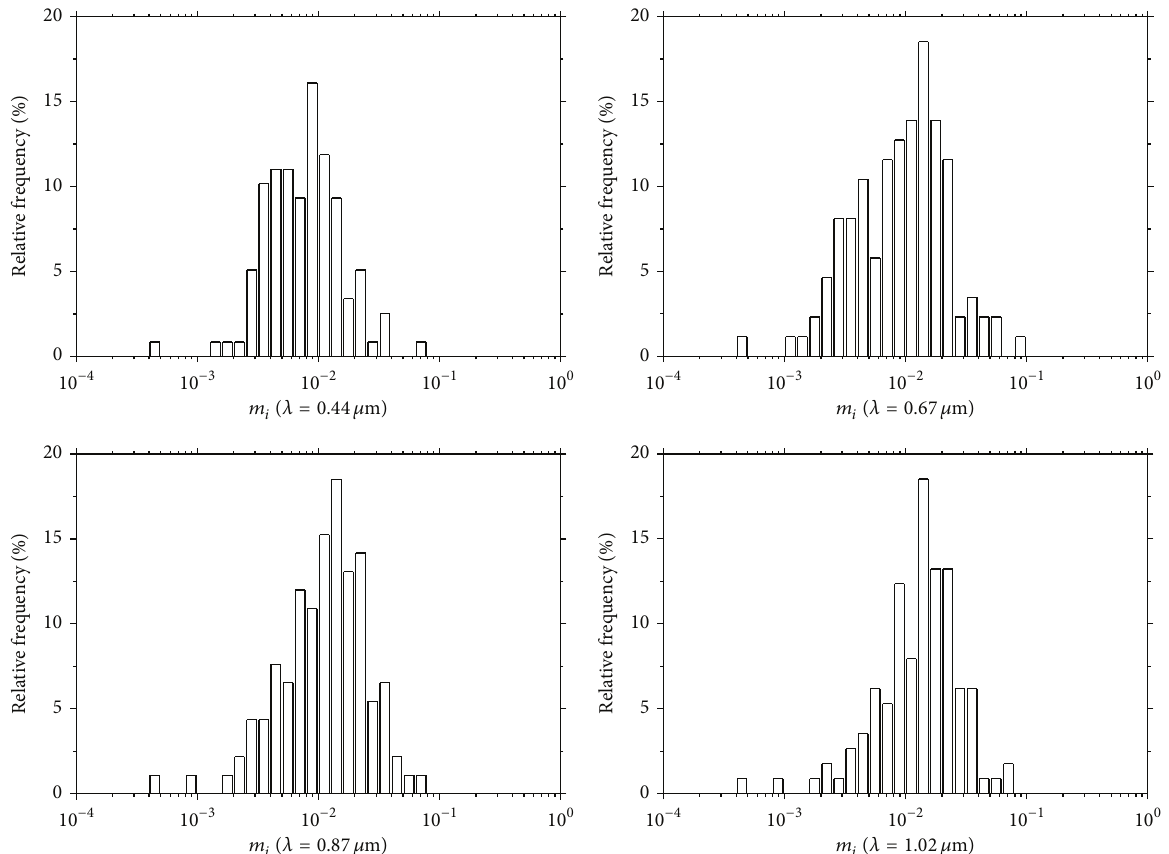
Figure 9: The histograms of the imaginary part of complex refractive index for dust aerosol at 0.44, 0.67, 0.87, and 1.02 𝜇 m.